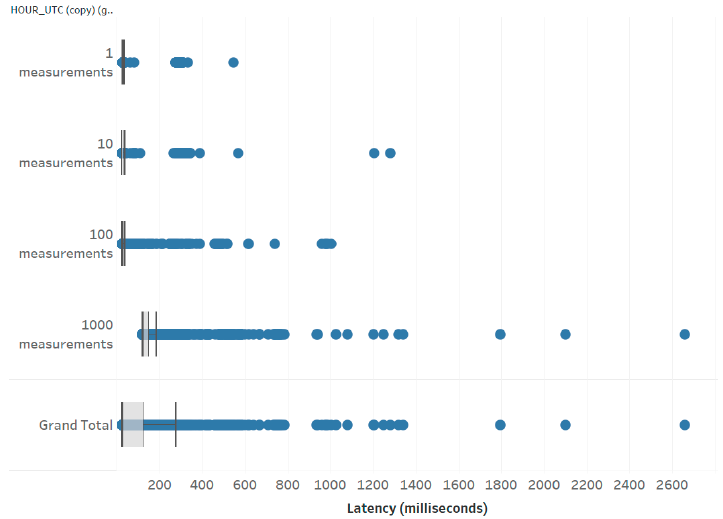
Figure 11. RI results for JaNDER Level 0 test.